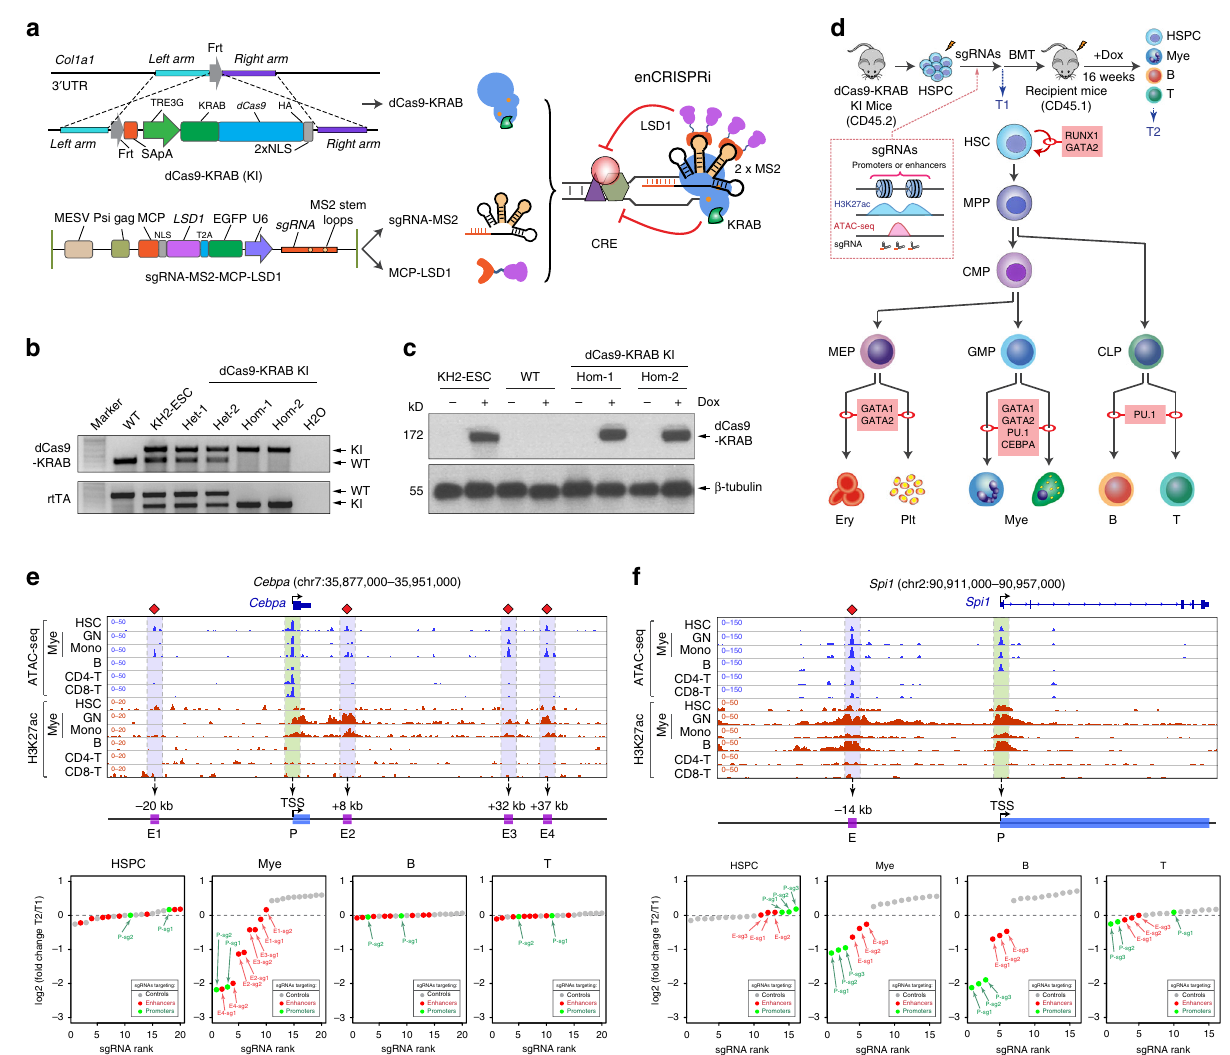
Fig. 5 Locus-speci fi c in vivo enhancer perturbation. a Schematic of site-speci fi c KI of tetracycline-inducible dCas9-KRAB into the Col1a1 locus. Coexpression of dCas9-KRAB, sgRNA-MS2 and MCP-LSD1 leads to assembly of enCRISPRi complex in vivo. b Validation of dCas9-KRAB and rtTA KI or WT alleles by genotyping PCR. C57BL/6 WT mouse and targeted KH2-ESC were used as controls. Two independent heterozygous (Het) and homozygous (Hom) KI mice were analyzed. c Dox-inducible expression of dCas9-KRAB fusion protein was con fi rmed by Western blot in the targeted KH2-ESC and two independent dCas9-KRAB KI mice. β -tubulin was analyzed as the loading control. d Schematic of in vivo perturbation of lineage-speci fi c enhancers in dCas9-KRAB KI mice. e In vivo enCRISPRi perturbation of Cebpa CREs revealed lineage-speci fi c requirement of Cebpa enhancers during hematopoiesis. Waterfall plots are shown for target-speci fi c sgRNAs (green and red dots) and nontargeting control sgRNAs (gray dots) by the mean normalized log2 fold changes in HSPCs, myeloid, T or B cells 16 weeks post BMT (T2) relative to pooled sgRNA-transduced HSPCs (T1) from two independent replicate screens ( n = 3 recipient mice per screen). Density maps are shown for ATAC-seq and H3K27ac ChIP-seq at the Cebpa locus (chr7:35,877,000 – 35,951,000; mm9) in bone marrow HSC, granulocytes (GN), monocytes (Mono), B, CD4 + and CD8 + T cells, respectively. The annotated Cebpa promoter (P) and enhancers (E1 to E4) are indicated by green and blue shaded lines. Results from independent replicate screens and statistical analyses are shown in Supplementary Fig. 7a, b. f In vivo enCRISPRi perturbation of Spi1 CREs during hematopoiesis. Density maps are shown for ATAC-seq and H3K27ac ChIP-seq at the Spi1 locus (chr2:90,911,000 – 90,957,000; mm9) in bone marrow HSC, GN, Mono, B, CD4 + and CD8 + T cells, respectively. The annotated Spi1 promoter (P) and enhancer (E) are indicated by green and blue shaded lines. Results from independent replicate screens and statistical analyses are shown in Supplementary Fig. 7c, d. Source data are provided as a Source Data fi